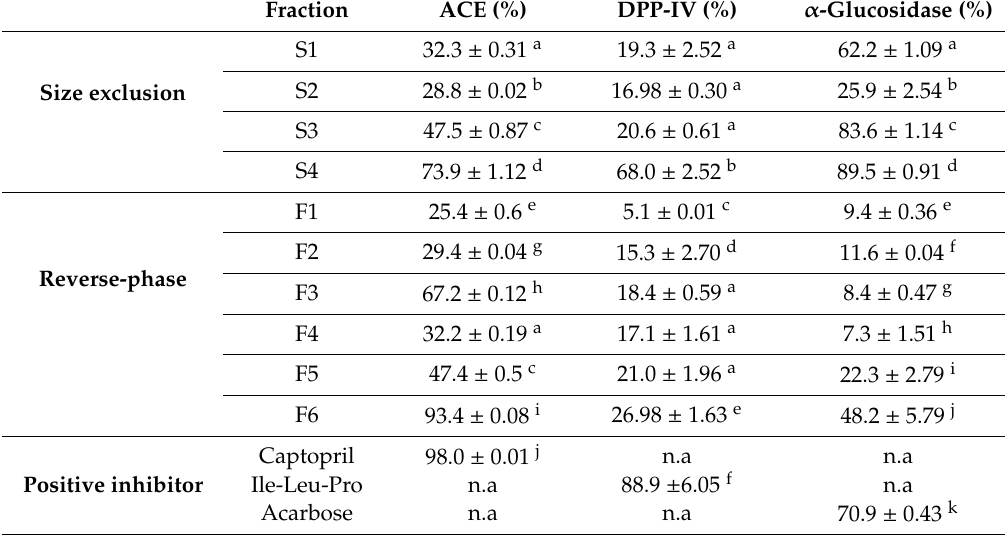
Table 1. Percentage inhibition of angiotensin converting enzyme (ACE), dipeptidyl peptidase-IV (DPP-IV), and α -glucosidase by CPH-digests (CPHD) peptide fractions.